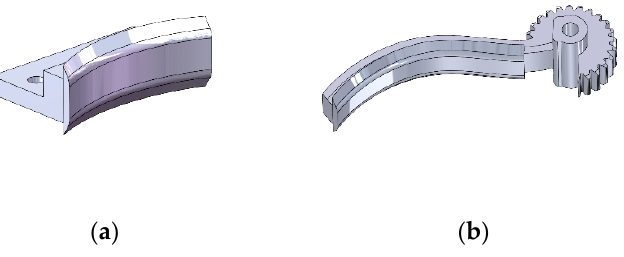
Figure 4. Cutting mechanism. ( a ) Front cutter head; ( b ) side cutter heads.